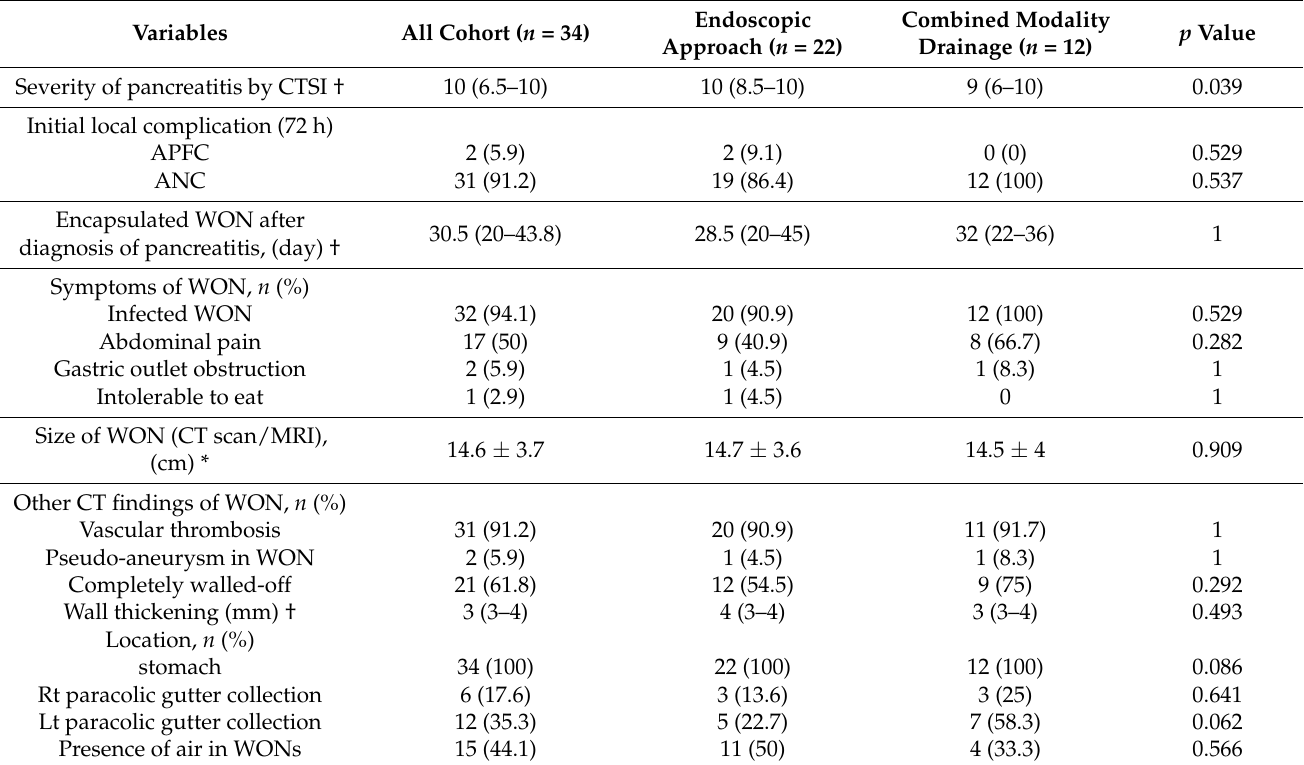
Table 2. Clinical and radiological characteristics of walled-off pancreatic necrosis.